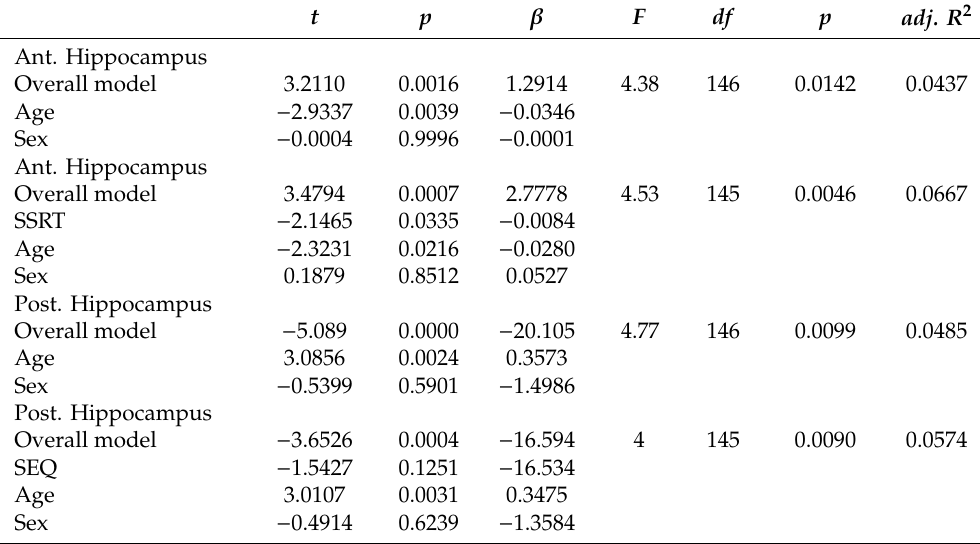
Table A2. Results of multiple regression analyses for the e ff ect size of anterior and posterior hippocampus activations. t p